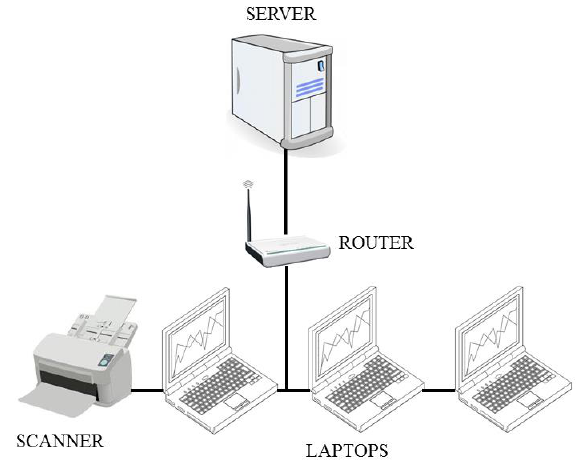
Figure 1. Main components of the pluviograph strip charts reader (PSCR).